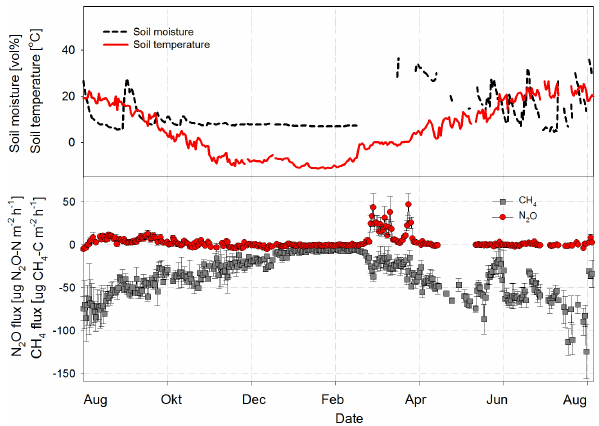
Fig. 2. Seasonal variability of daily average soil volumetric water content (at 0–6cm depth) and soil temperature (at 5cm depth) as well as of soil nitrous oxide and methane fluxes at the semi-arid steppe site in Inner Mongolia for the period 15 August 2007 to 15 August 2008.